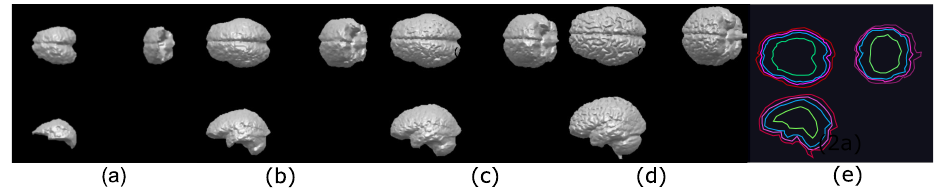
Figure 12. Illustration of the control in the reconstruction process by applying the hyperconnected lower leveling to the volume used in Figure 11 by varying the slope α : ( a ) α = 22; ( b ) α = 15; ( c ) α = 10; and ( d ) α = 5; ( e ) contours illustrating the reconstruction process of the brain using the leveling, with, α = 22 in green, α = 10 in blue, α = 10 in fuchsia, and α = 5 in purple.